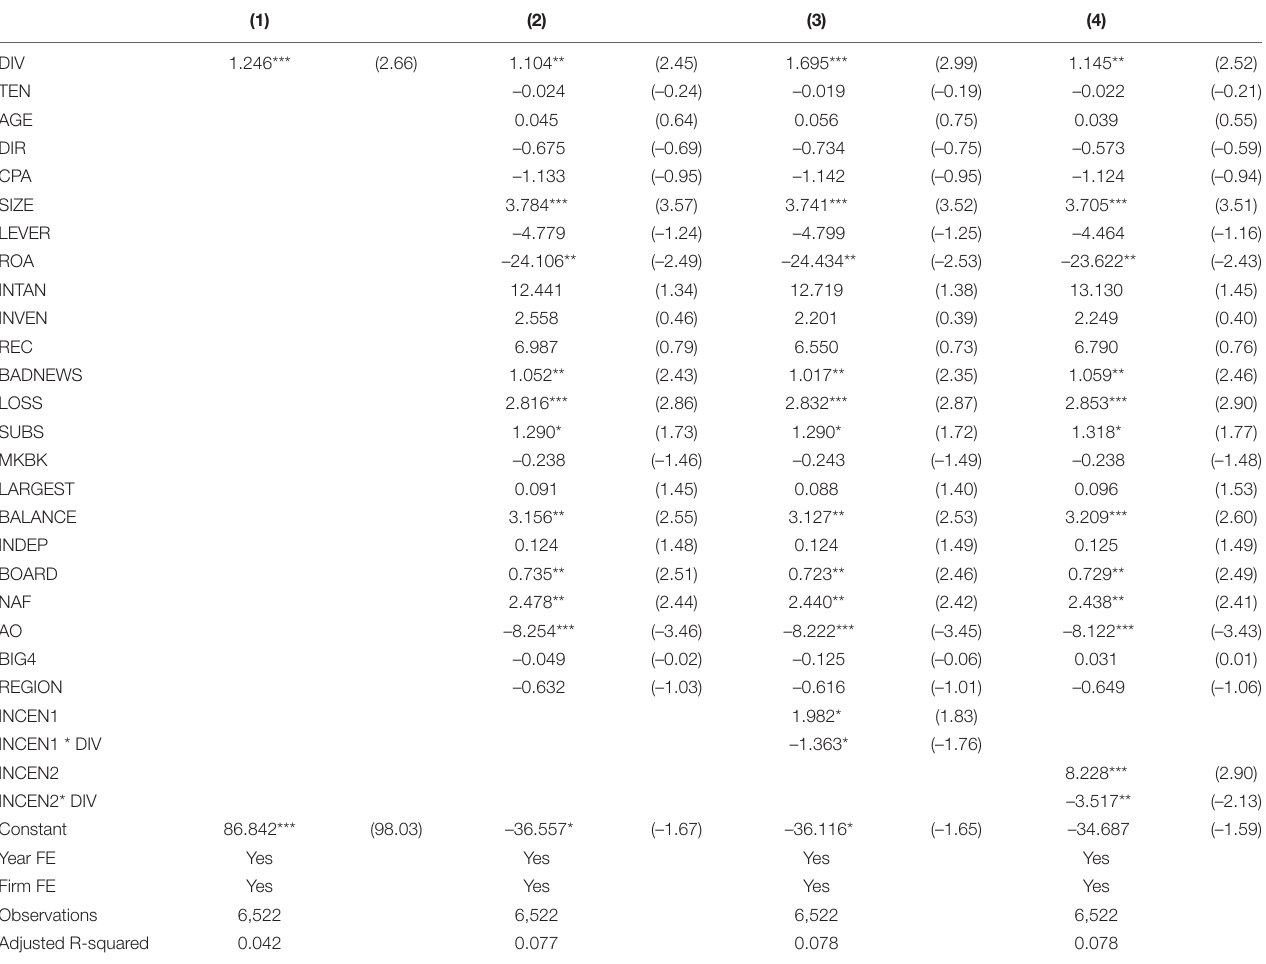
TABLE 3 | CFO functional diversity and timeliness for SOEs